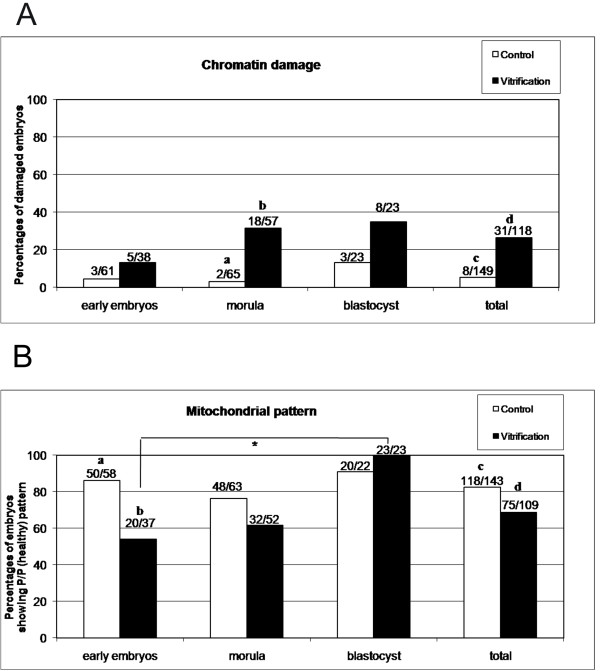
Effects of vitrification on chromatin integrity and mitochondrial distribution pattern of mouse 4/16-cell, morula and blastocyst stage embryos. Panel A: overall percentages of embryos (grade B + grade C) with damaged chromatin observed after vitrification (black bars), grouped according to their developmental stage, and compared with controls (white bars). In detail, in embryos at the morula stage, vitrification increased the rate of embryos showing chromatin damage whereas it had no effect in early embryos and in blastocysts. Chi square test: within each stage: a,b P<0.001; c,d P<0.05. Panel B:Percentages of embryos showing the P/P mt pattern observed after vitrification (black bars), grouped according to examined developmental stages, and compared with controls (white bars). In detail, in embryos at the 4/16-cell stage, vitrification reduced the rate of embryos showing P/P mt pattern whereas it had no effect in embryos at the morula and blastocyst stages. Chi square test: a,b P<0.001; c,d P<0.05; * P<0.001. Numbers of analyzed oocytes per group are indicated on the top of each histogram.